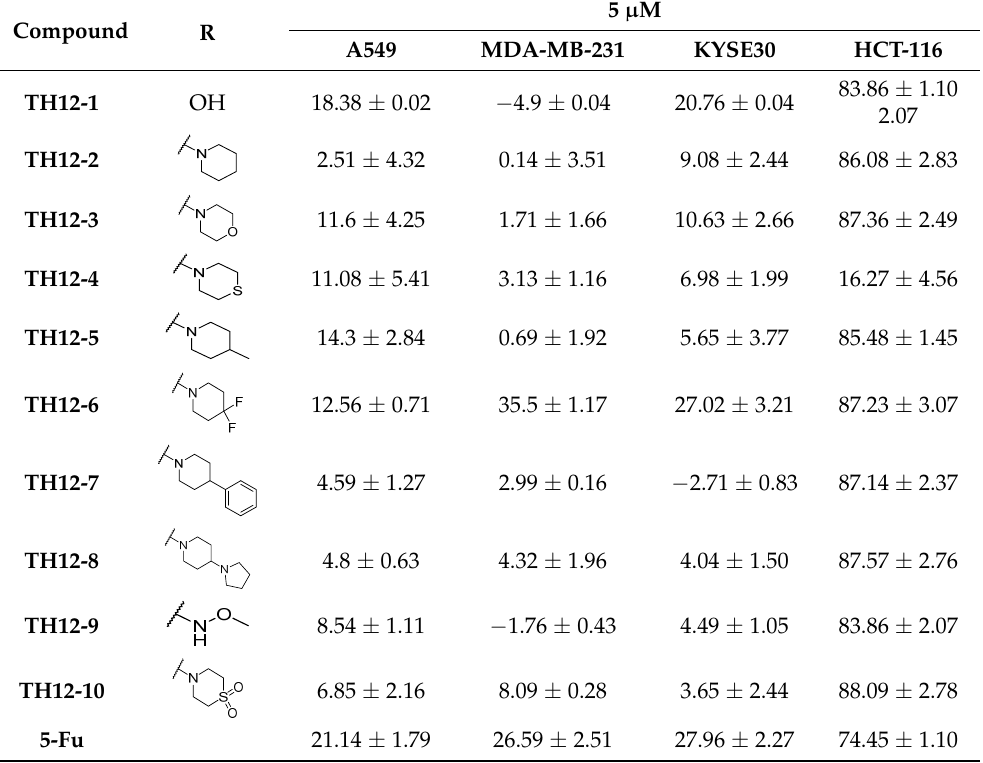
Table 1. Inhibition rates (%) of compounds TH12-2 ~ TH12-10 against human tumor cells at 5 μ M. Compound